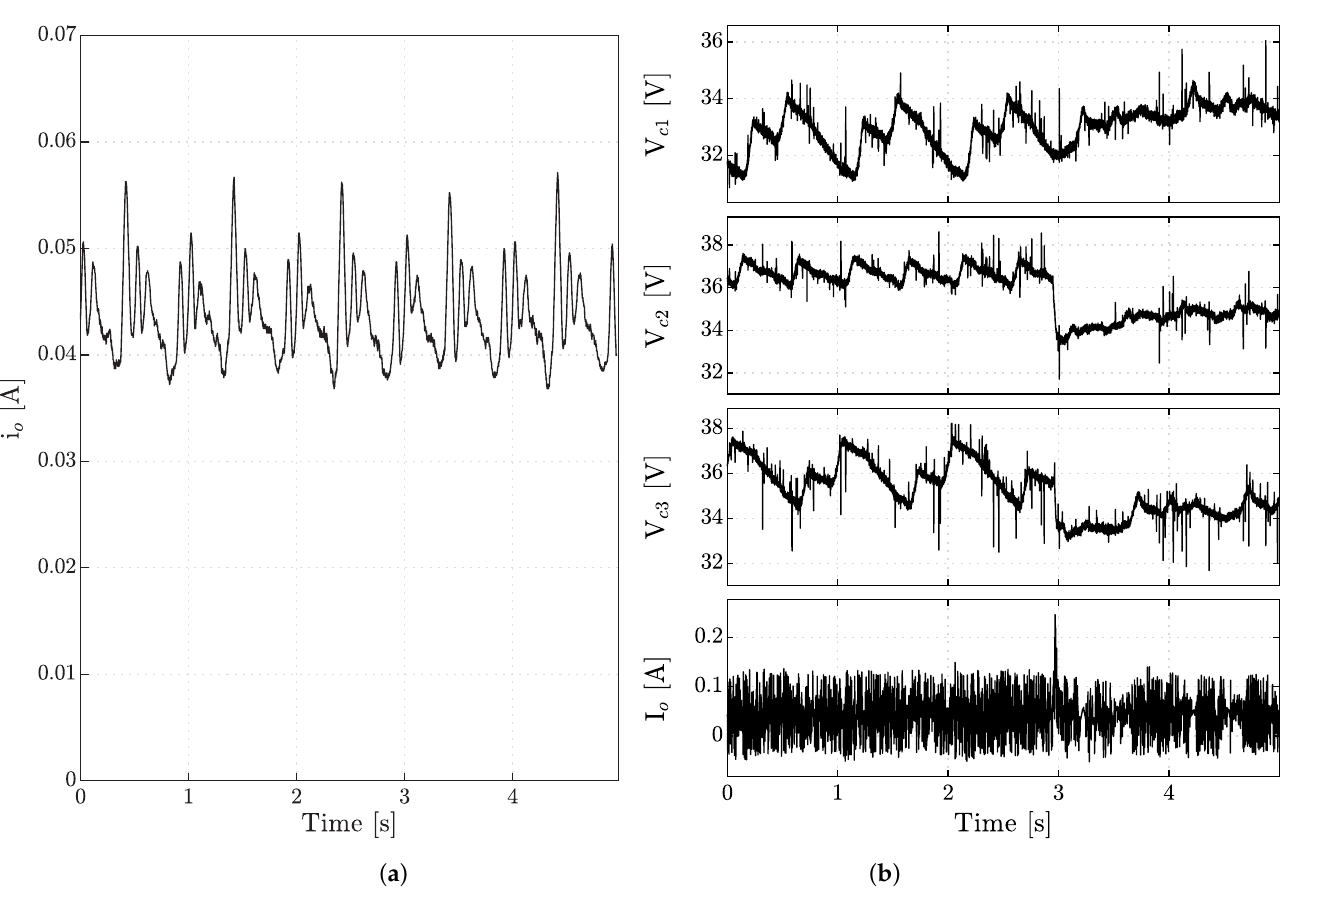
Figure 9. Experimental results. ( a ) Output current; ( b ) performance of the capacitor balance